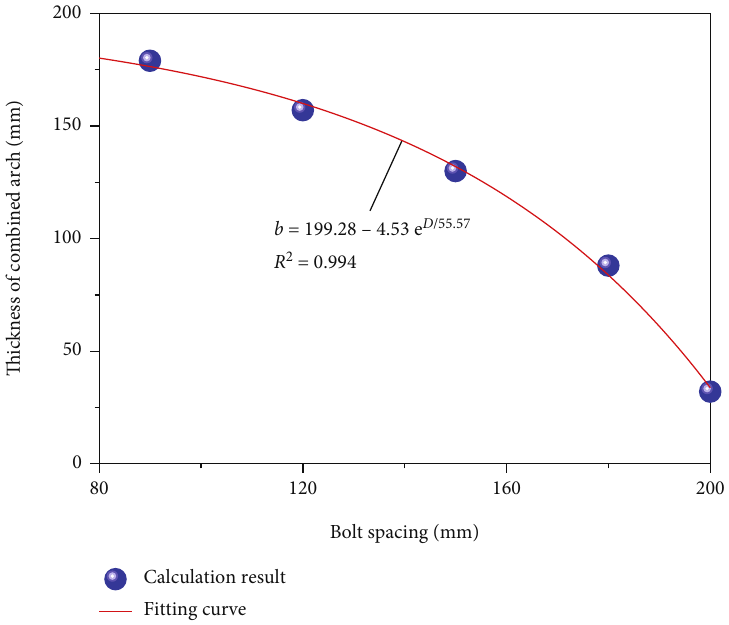
Figure 15: E ff ect of bolt spacing on the thickness of combined